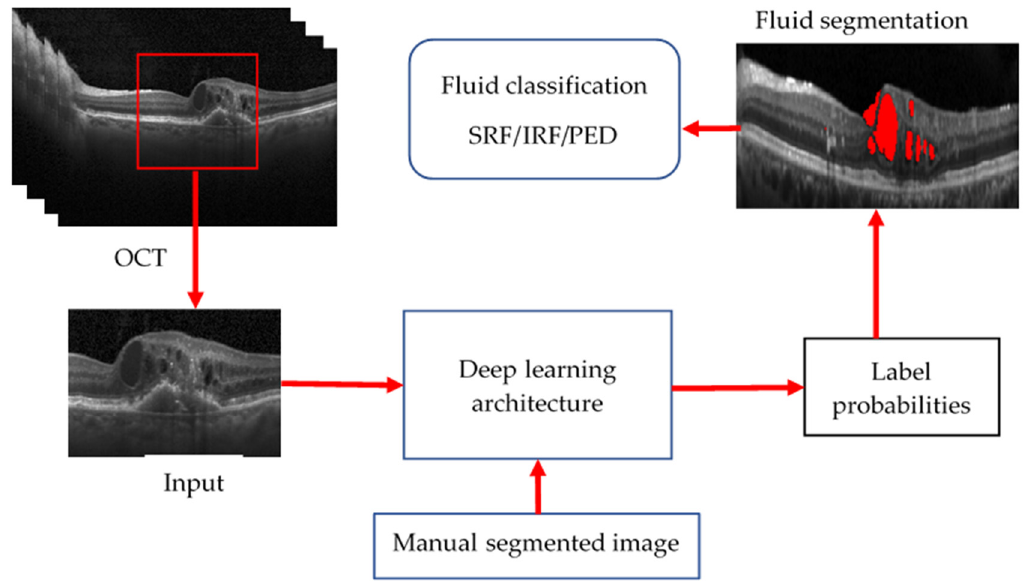
Figure 16. General procedure of AI-based OCT layer segmentation.